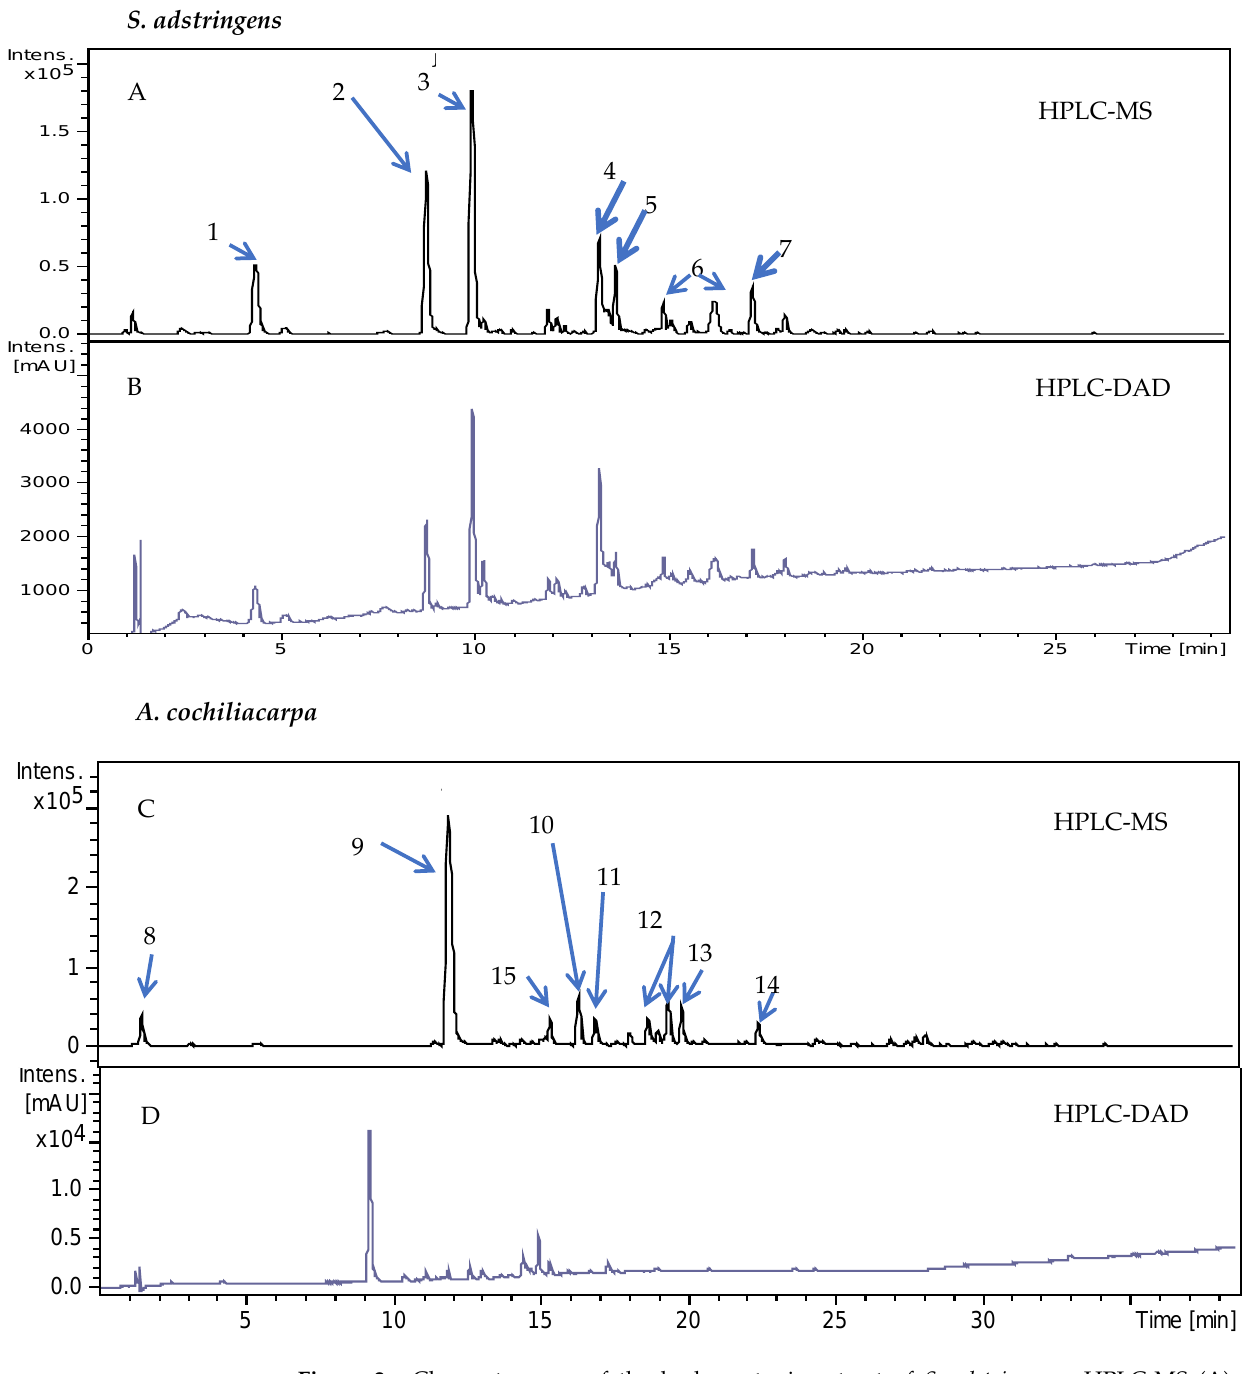
Figure 2. Chromatograms of the hydroacetonic extract of S. adstringens — HPLC-MS ( A ) and from HPLC-DAD ( B ); chromatograms of the hydroacetonic extract of A. cochliacarpa obtained from HPLC-MS ( C ) and from HPLC-DAD ( D ). Captions: (1) gallocatechin; (2) epigallocatechin; (3) o -methyl-epigallocatechin; (4) epigallocatechin; (5) o -methyl-epigallocatechin Isomer; (6) di- o -ethyl- prorobinetinidin -prodelphinidin; (7) o -methyl-epigallocatechin- o -gallate; (8) di- o -hydroxide; (9) catechins and procyanidin dimers ; (10) o -desoxyhexosil-hexoside; (11) procyanidin dimers; (12) procyanidin- o -gallate dimers; (13) procyanidin dimers; (14) epigallocatechin; (15) epicatechin.